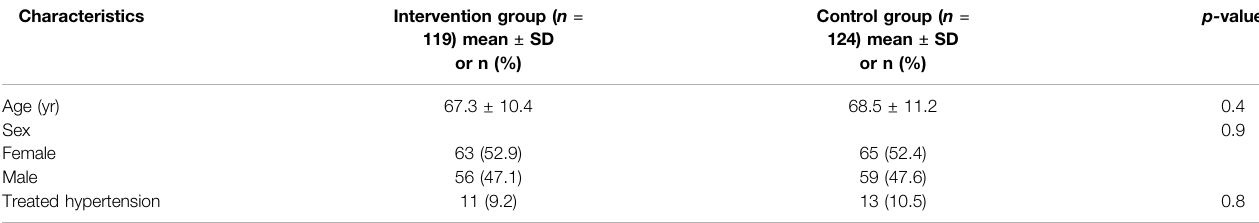
TABLE 1 | Baseline characteristics of patients undergoing cataract surgery. Characteristics